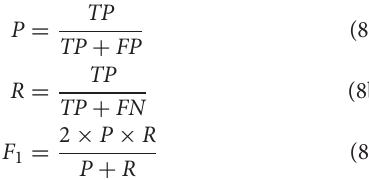
improvement skills, the algorithm comprised of the Darknet18 backbone and the ResBlock neck, the algorithm comprised of efficient backbone and the ResBlock